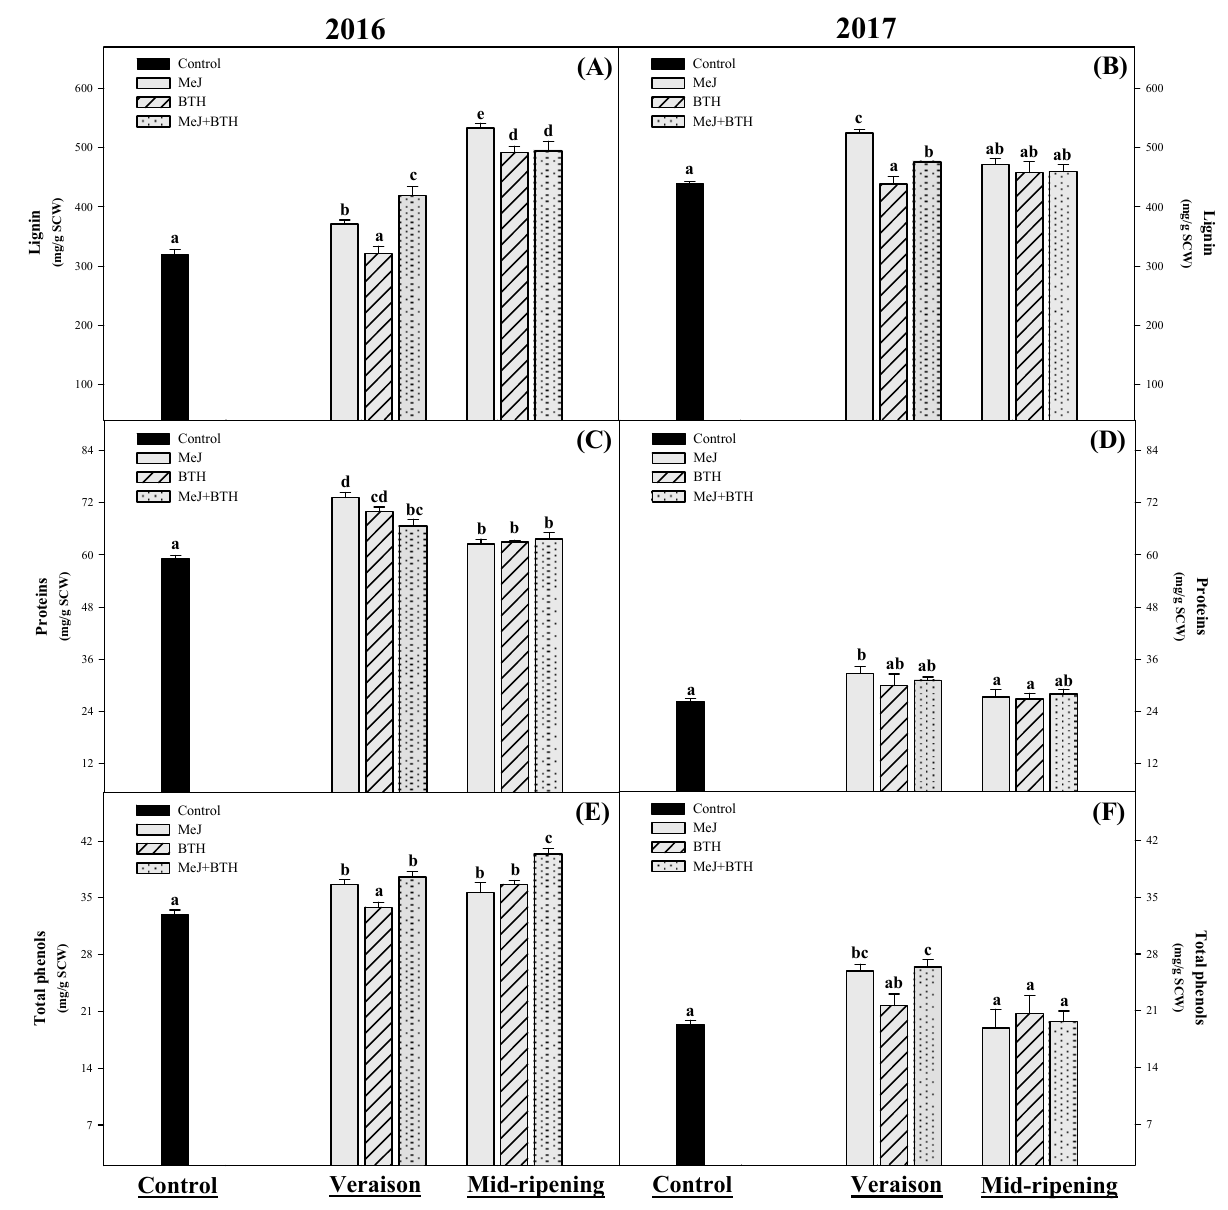
Figure 4. Concentration of lignin ( A , B ), proteins ( C , D ) and total phenols ( E , F ) of Monastrell grape skin cell walls, during two seasons (2016 and 2017). Different letters indicate significant differences according to Duncan’s test ( p < 0.05). Abbreviations: MeJ, methyl jasmonate; BTH, benzothiadiazole.